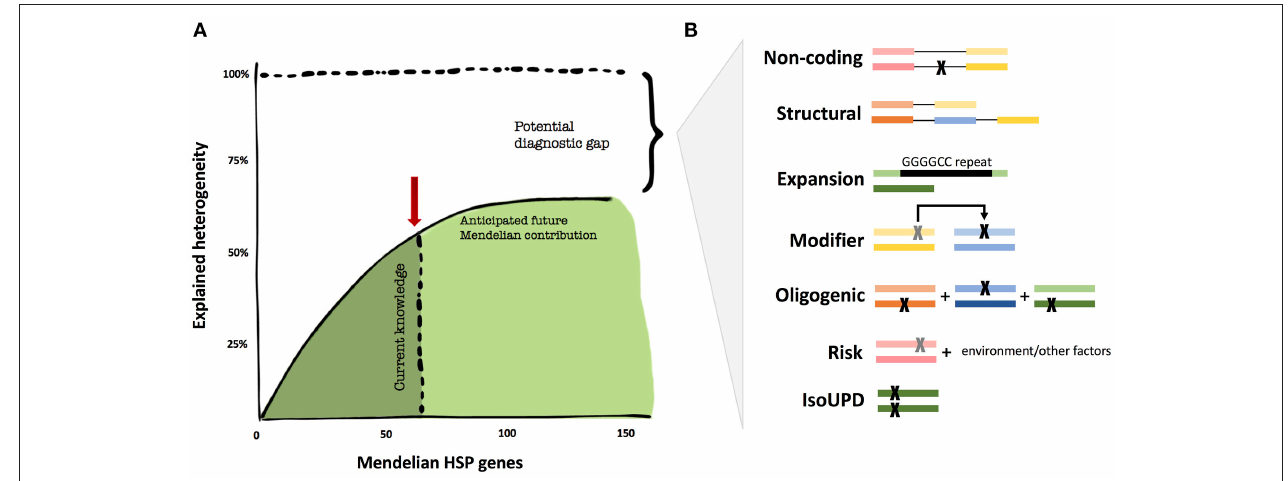
FIGURE 1 | The diagnostic heritability gap in HSP. (A) Despite unprecedented success in the identification of additional Mendelian genes, the diagnostic yield may not get close to 100% in HSP, but rather reach an asymptotic ceiling. (B) Areas that are potentially understudied in HSP thus far for cost and technical challenges. These include uncommon Mendelian causation, but also modifier and oligogenic risk alleles. The colored bars represent genes, the black lines connecting genes represent noncoding regions, and each “X” represents a